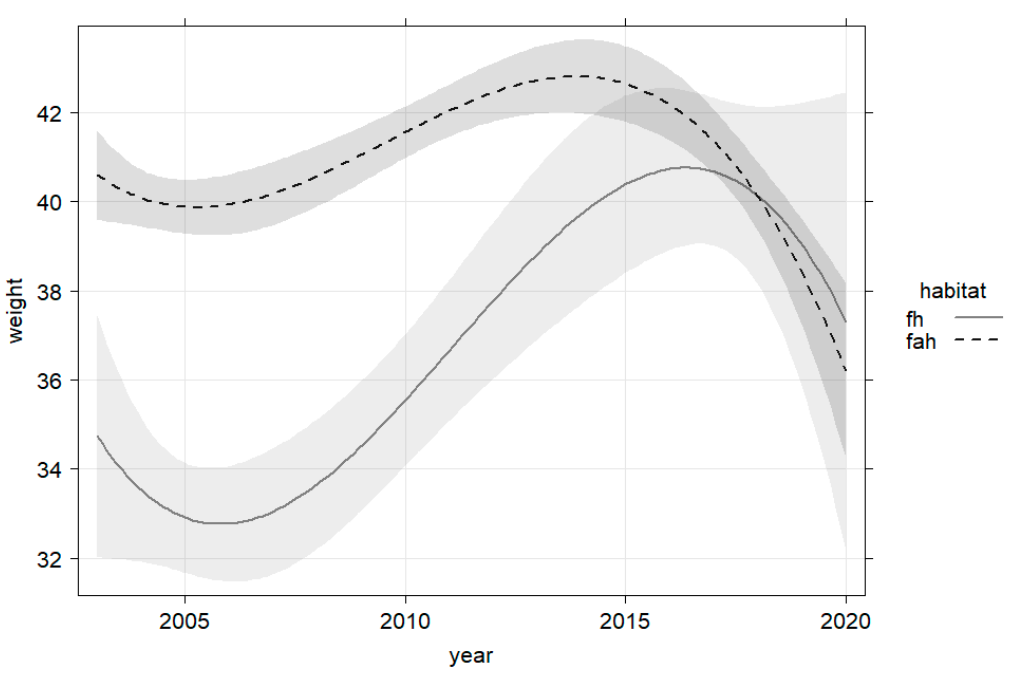
Figure 2. Bw (weight) of wild boar females (all ages) increased with hunting year until about 2017, followed by a decline that was less pronounced in agricultural dominated habitat fah ( n = 2837).